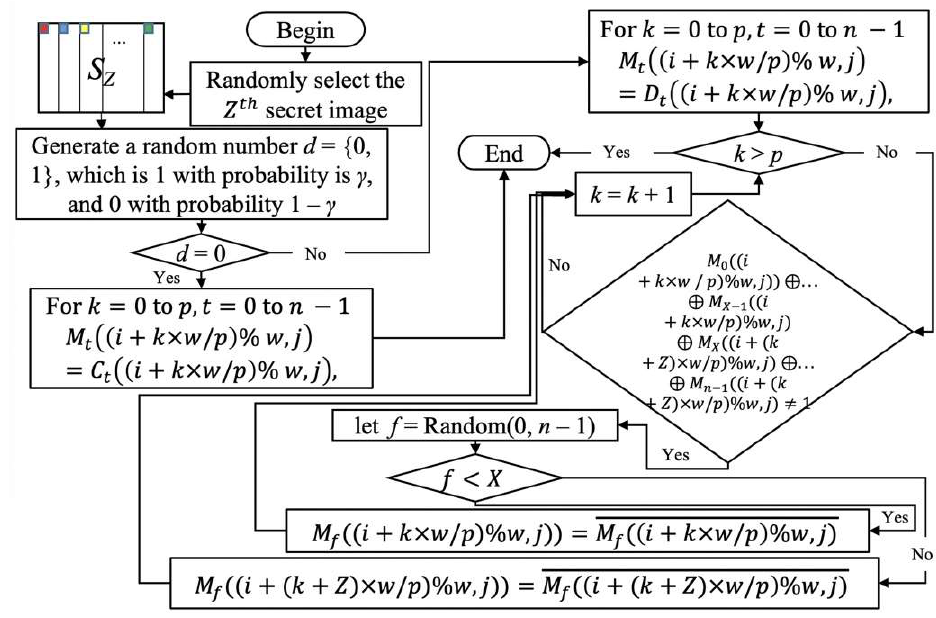
Figure 7. The flow chart of Method 2 Steps 1–4.